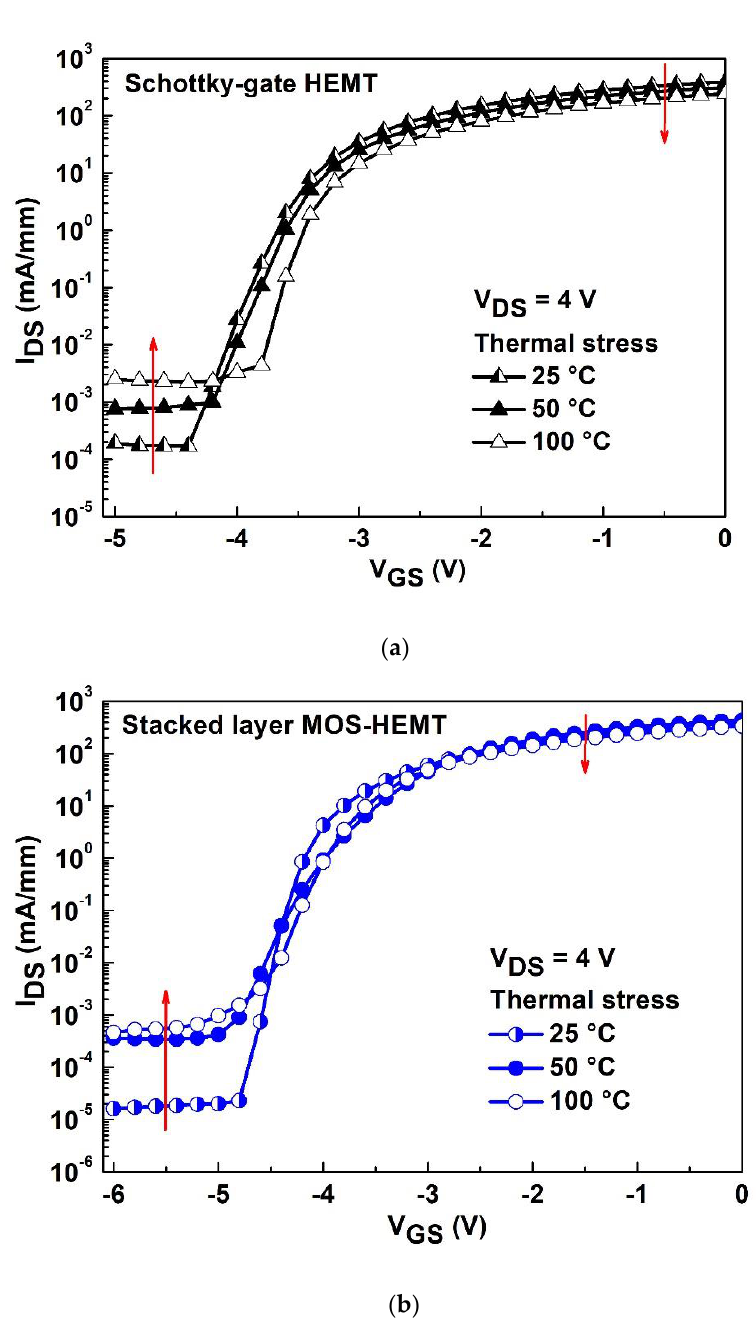
Figure 8. Subthreshold characteristics with various temperatures ranged from 25 °C to 100 °C for ( a ) the Schottky-gate HEMT and ( b ) the stacked layer MOS-HEMT.